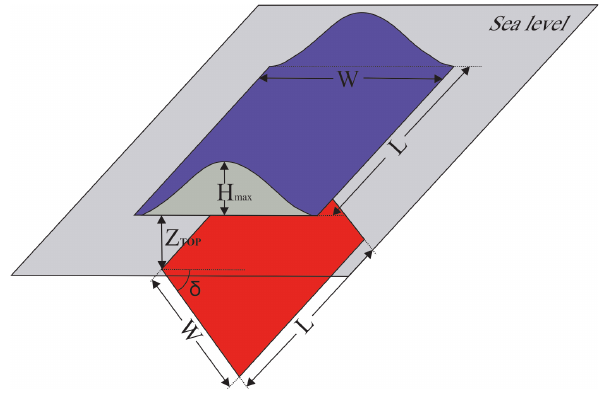
Fig. 1. Fault plane and sea bottom displacement used in the scenario